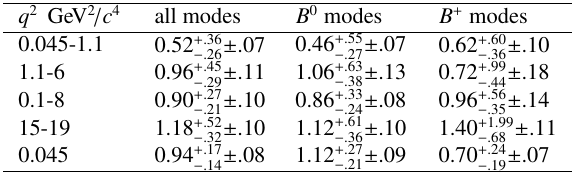
and R K ∗ + . The first uncertainties K ∗ 0